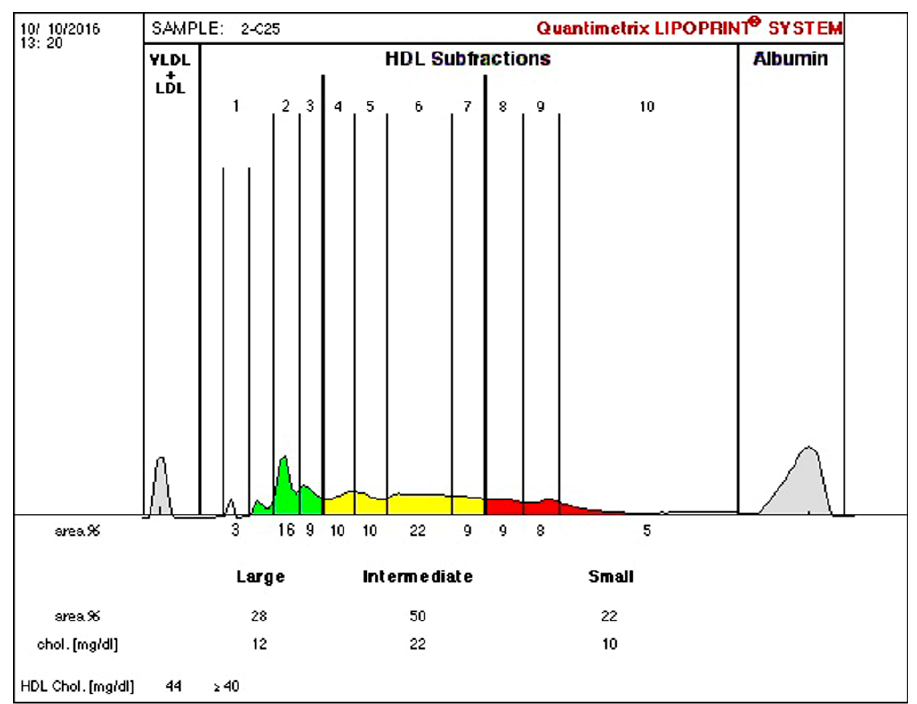
Figure 2. HDL ‐ C separation after therapy, indicating 28% of large (green), 50% of intermediate (yellow), and 22% of small (red) HDL sub ‐ fractions.